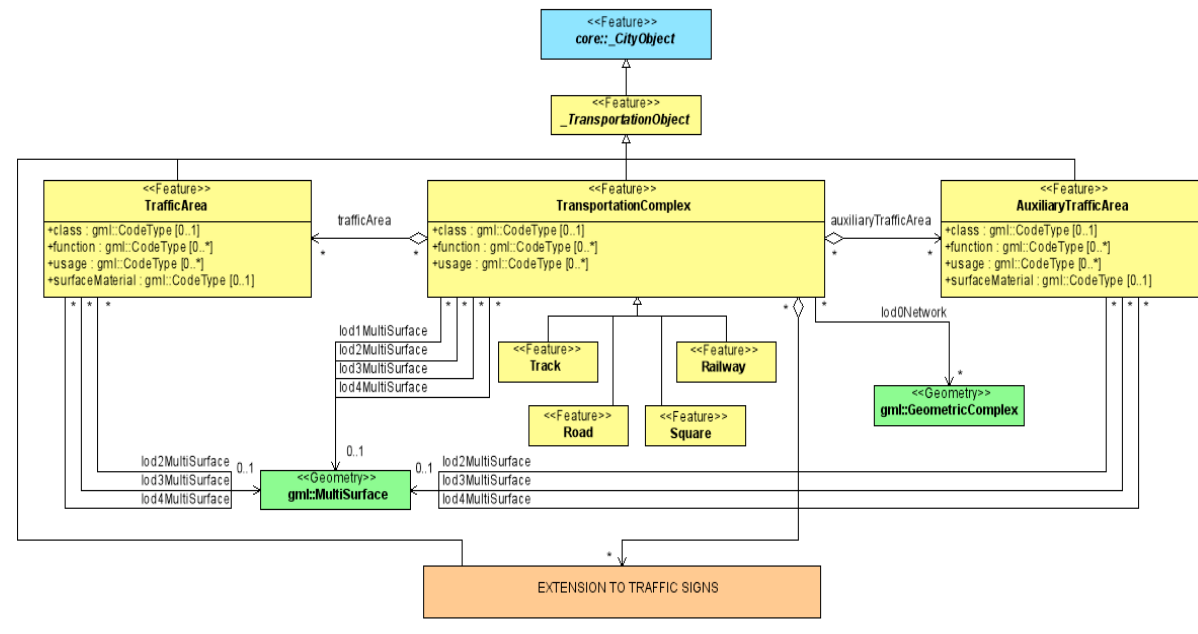
Figure 6. UML diagram of Transportation module including an extension for traffic